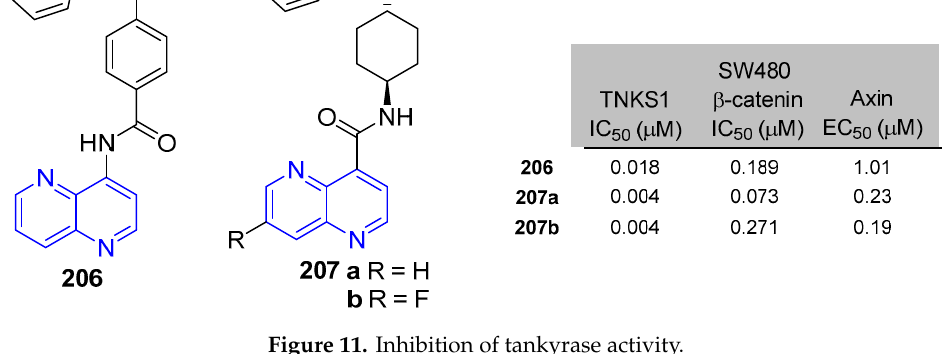
Figure 11. Inhibition of tankyrase activity.